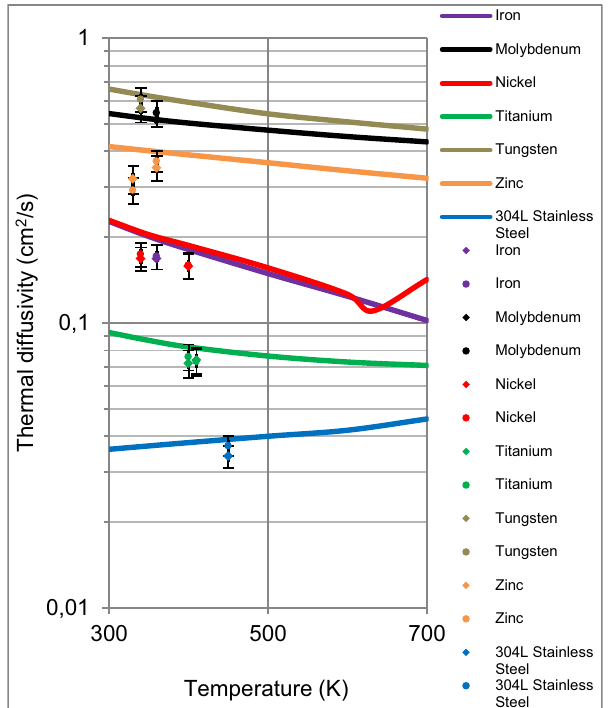
Fig. 5. Comparison of the measured thermal diffusivities along with the referenced values from literature (presented as solid lines) [8]. The square points – D m2 and the circle points – D m1 (see Tab. 1 for D m de fi nition).